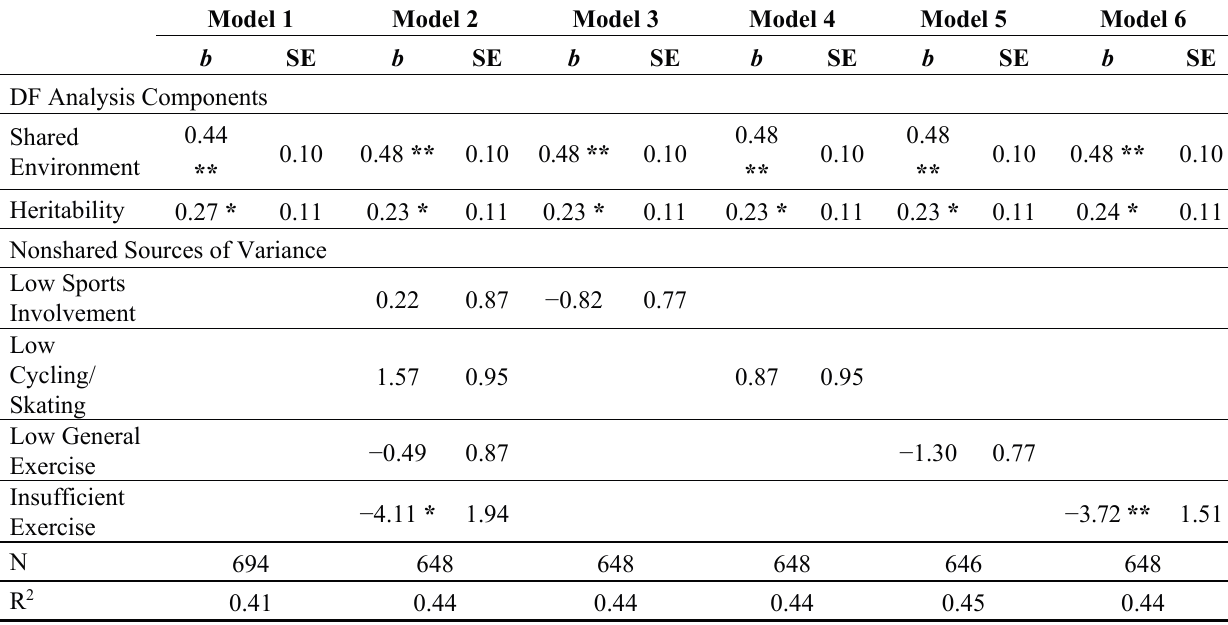
Table 3. DF analysis of the shared environment, heritability, and adolescent physical fitness as predictors of verbal intelligence during early adulthood verbal intelligence (wave